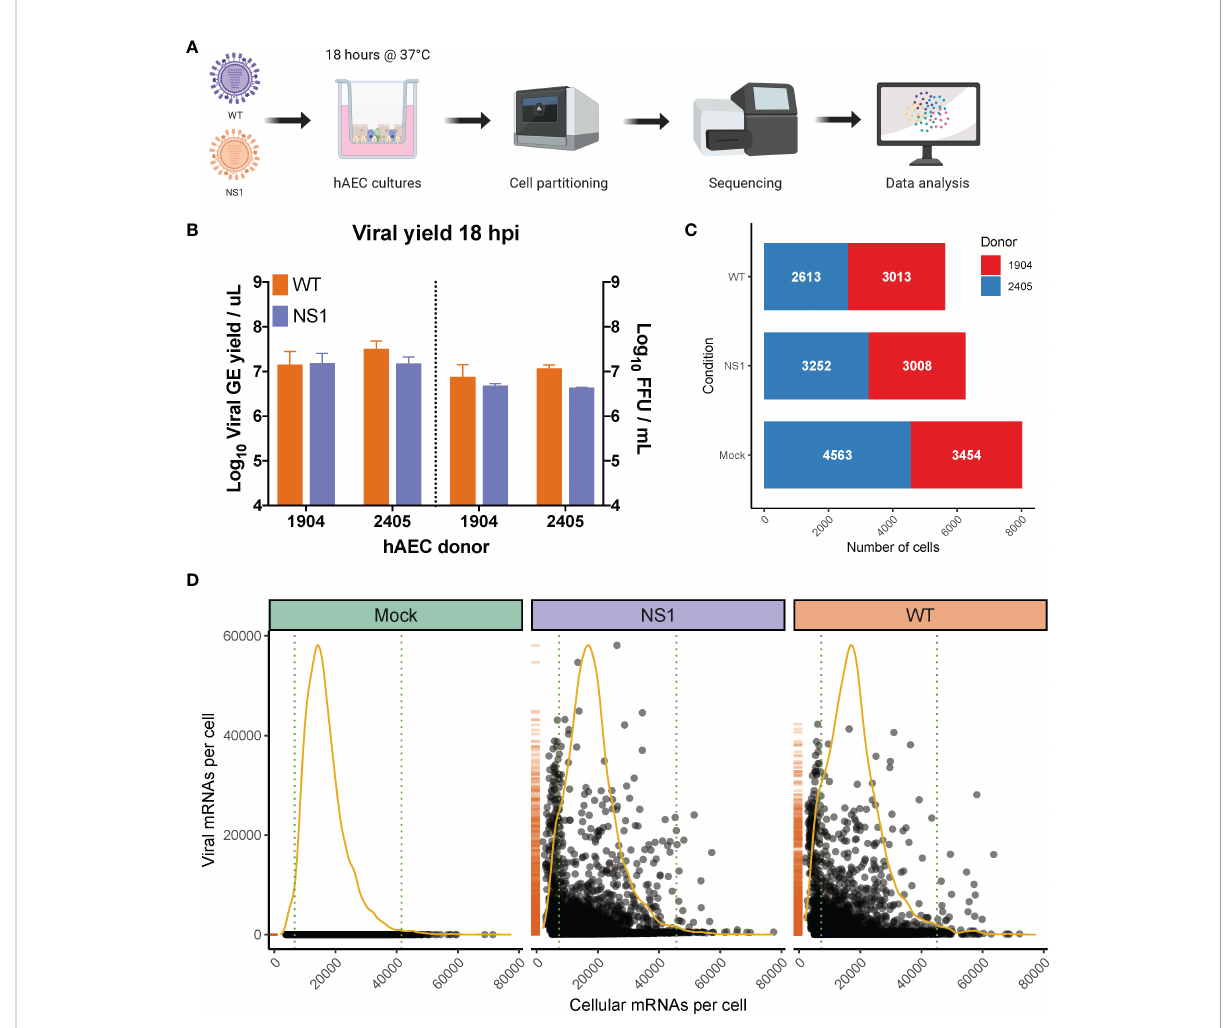
FIGURE 1 Overview of scRNA-seq work fl ow and evaluation of captured single cells. (A) Overview of the experimental work fl ow for scRNA-seq analysis. Primary well-differentiated hAEC cultures were infected with either wild-type pandemic IAV (WT) or a mutant version of IAV (NS1 R38A ) that no longer antagonizes the host antiviral response. Cells were harvested 18 hours post-infection (hpi) and then partitioned into single cells using the Chromium Controller (10x Genomics). mRNA from single cells was subsequently reverse transcribed into cDNA and cDNA libraries were prepared and sequenced on the Illumina platform. The Cell Ranger pipeline (10x Genomics) was used to align and count both host and viral reads in individual cells and a variety of software packages were employed for downstream data analysis. (B) Quanti fi cation of apical viral yield at 18 hpi for hAEC cultures that were derived from 2 distinct biological donors (1904 and 2405). Apical viral yield was determined for both WT (orange) and NS1 R38A (purple) virus-infected conditions and is given as the viral RNA yield (genome equivalents/µL; left y-axis) and viral titer (Focus Forming Units (FFU)/mL; right y-axis). (C) Stacked bar graph illustrating the number of single cells captured for analysis. Shown for mock, WT, and NS1 R38A virus-infected hAEC cultures for each biological donor (donor 1904 shown in red, donor 2405 shown in blue). (D) Scatter plot displaying the total number of host and viral mRNAs per cell for each condition (mock in green, NS1 R38A in purple, WT in orange). Each point in the graph represents an individual cell. The global distribution for host mRNA is shown as a yellow line, whereas the global distribution of viral mRNA is depicted as an orange rug